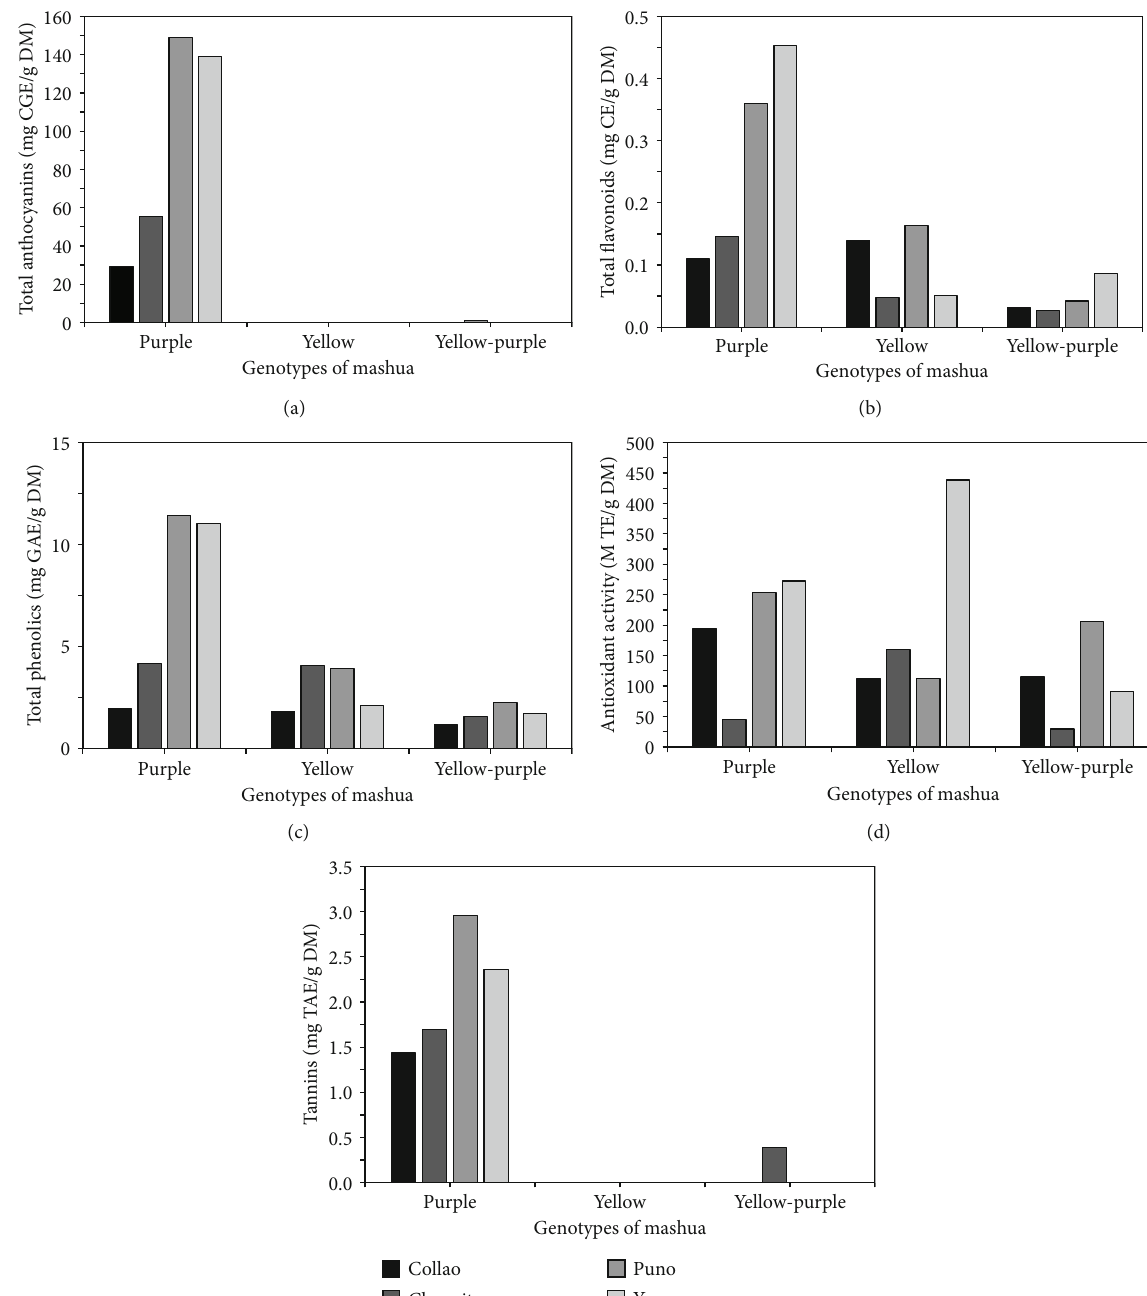
Figure 3: E ff ect of agroecological areas on the content of total anthocyanins (TA), total fl avonoids (TFA), total phenolics (TP), activity antioxidant (CA), and tannins (TA) from the three mashua genotypes ∗ . ∗ Three mashua genotypes are yellow, purple, and yellow-purple. Expressed in DM (dry matter), GAE (gallic acid equivalents), TE (Trolox equivalents), CGE (cyaniding 3-glociside equivalents), CE (catechin equivalents), TAE and (tannic acid equivalents). The means within a row with di ff erent letters are signi fi cantly di ff erent at p < 0 : 05 . ND: not